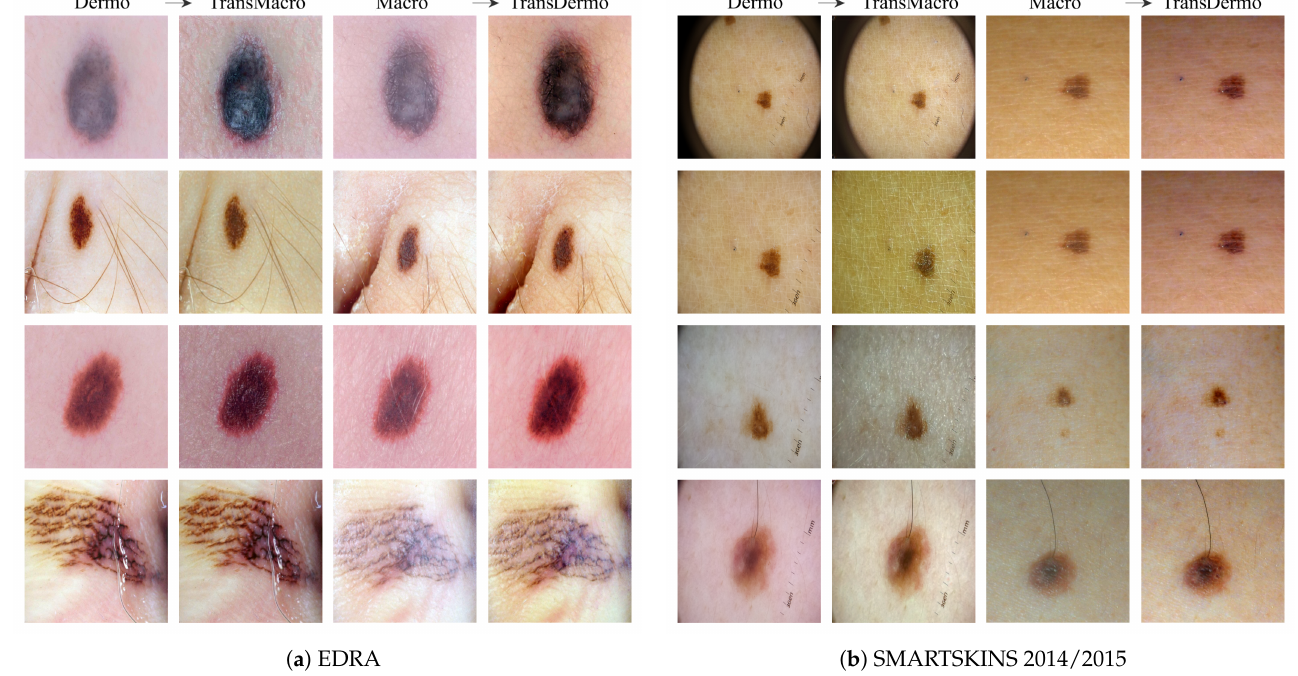
Figure 3. Examples of the translation between domains in EDRA ( a ) and SMARTSKINS 2014/2015 ( b ) tests subsets. For each subfigure, from left to right: pair Dermo → TransMacro and pair Macro →